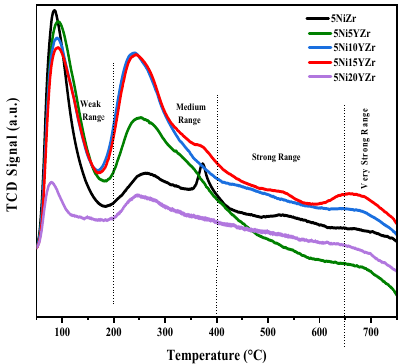
Figure 3. CO 2 -TPD patterns of prepared Figure 3. CO 2 ‐ TPD patterns of prepared catalysts.